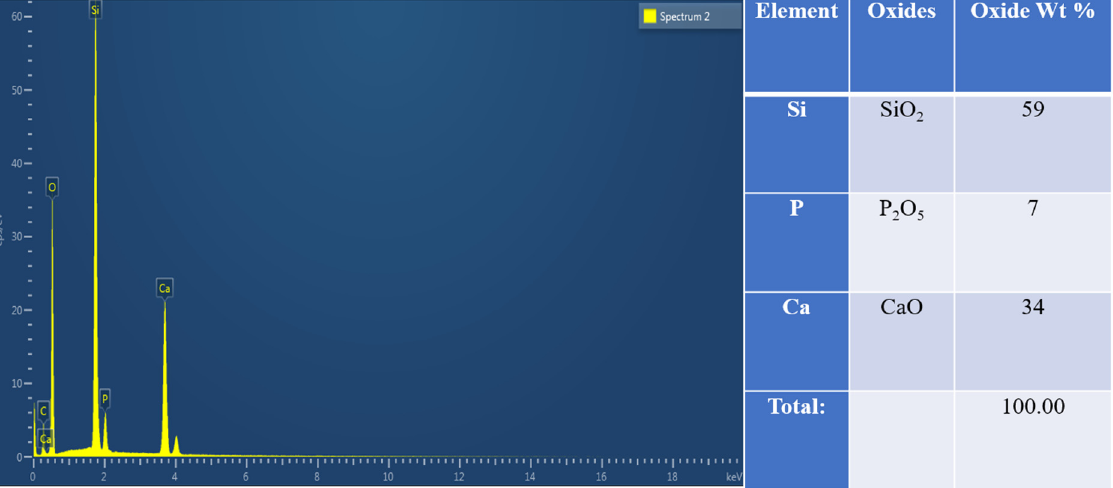
Figure 2. EDX analysis describing the weight percentages of oxides in MBGNs.